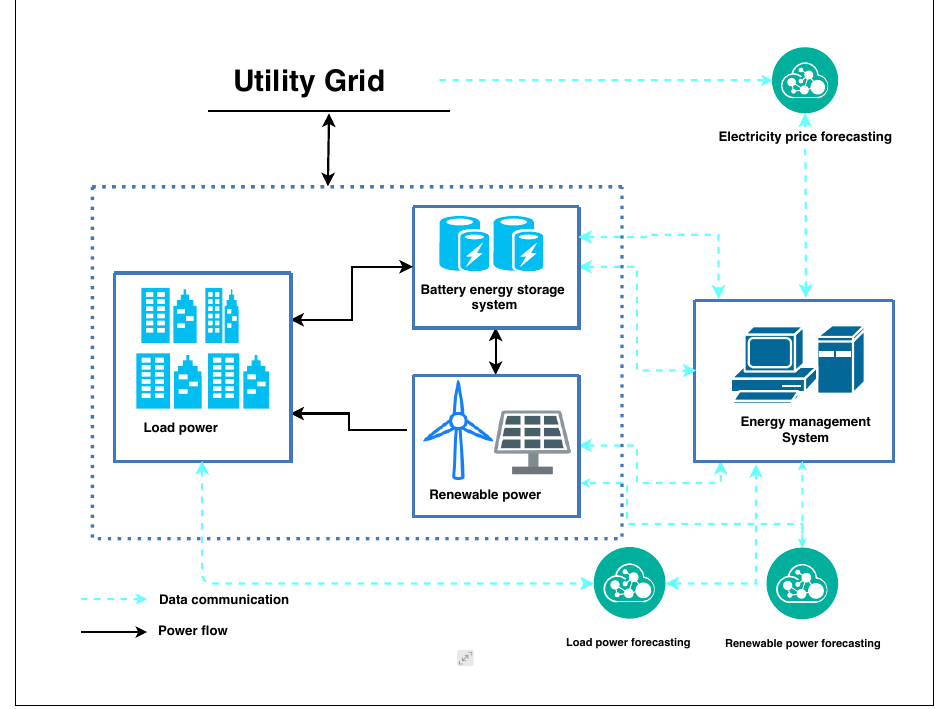
Figure 1. Configuration of the